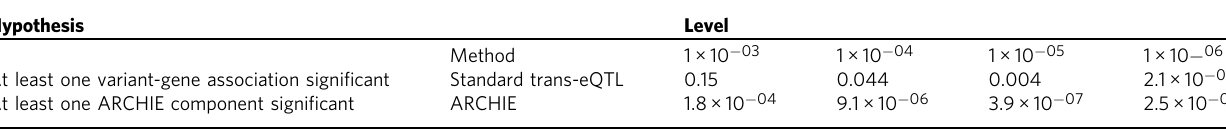
Table 1 Type-I error of ARCHIE under the global null hypothesis of no association between the SNPs and gene network as shown in Fig.